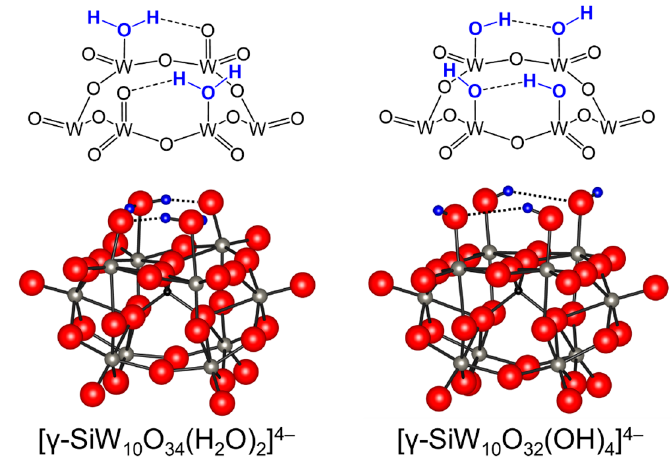
Figure 4. Figure 4. Schematic representations of the lacunary sites on [ γ -SiW 10 O 34 (H 2 O) 2 ] 4 − and [ γ - SiW 10 O 32 (OH) 4 ] 4 − [82,83].